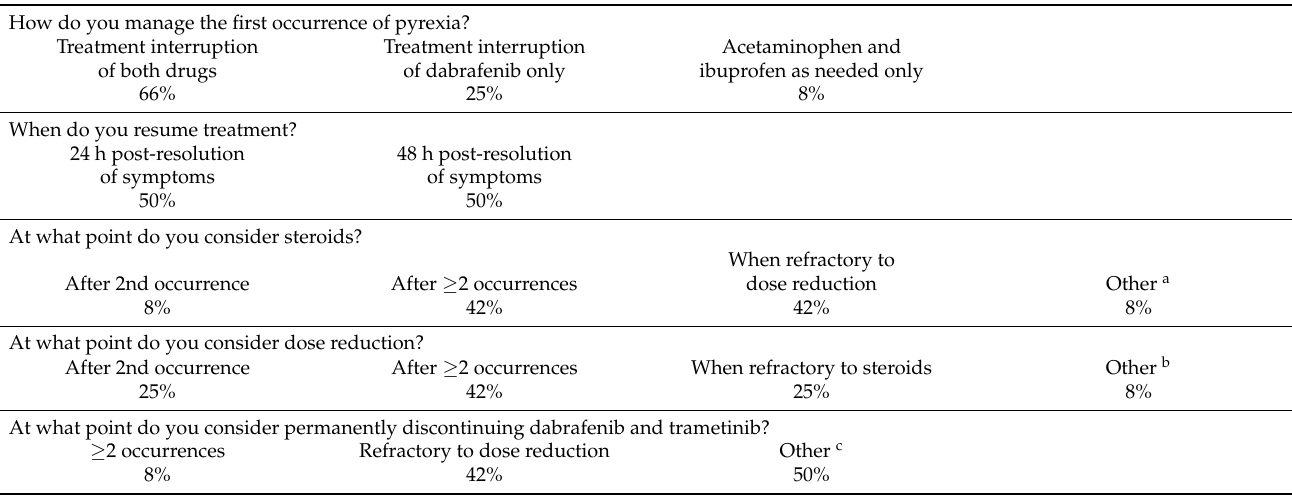
Table A1. Management of Dabrafenib and Trametinib-related Pyrexia in Canadian Routine Practice: Preliminary Survey of Canadian Centres (N =